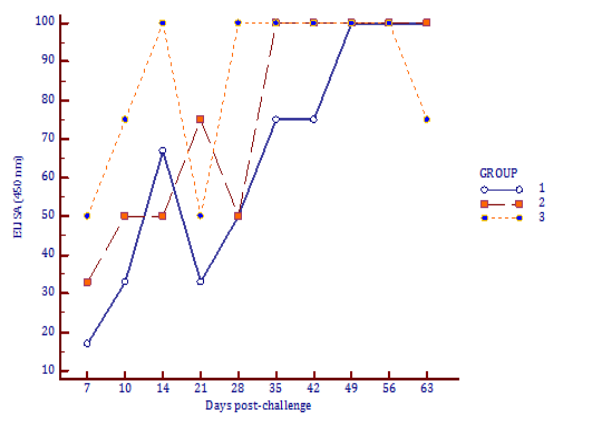
Figure-2. PCR of blood samples on day 7 pi. M: 1-kb standard ladder, Lane 1: negative control, Lane 2: positive control, Lane 3-10: positive